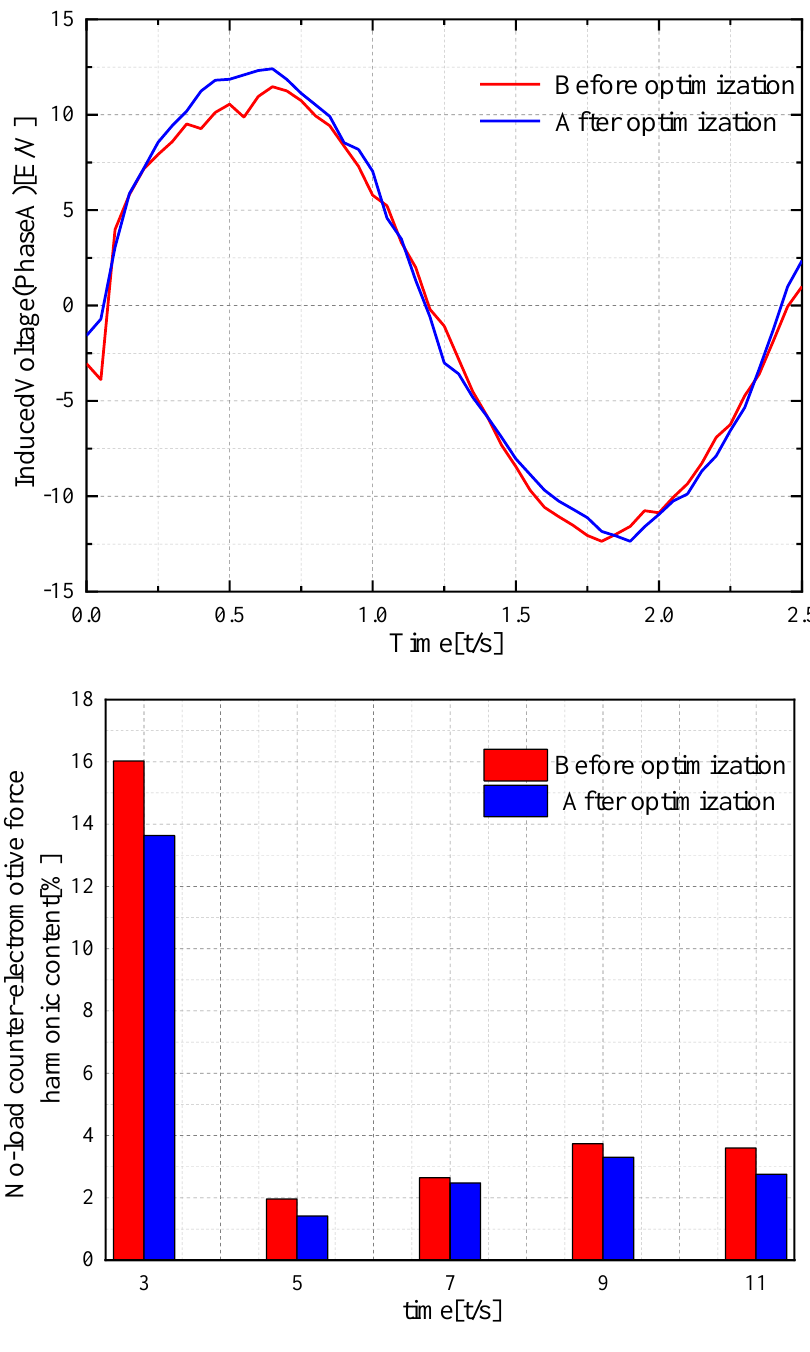
Figure 7. Back EMF. The output torque graph of the AFPMBLDC is shown in Figure 8. The motor’s average output torque before optimization was 0.504 Nm, while after optimization, the average output torque was 0.491 Nm, a 2.5 percent reduction. The motor torque ripple after optimization is 4.3 percent lower than before optimization, with a smoother waveform and improved motor